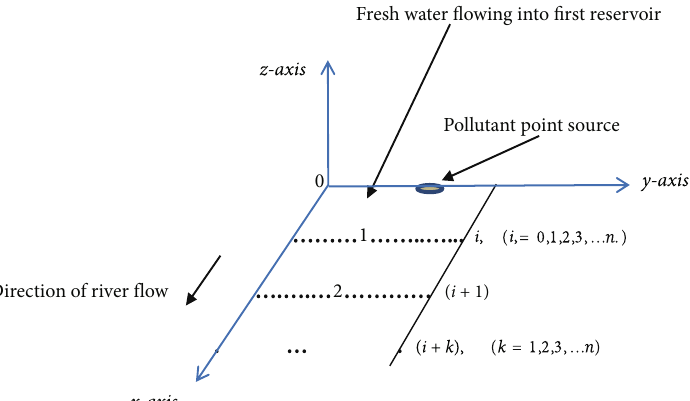
Figure 2: Setup for discretization of River fl ow channel into cascading water reservoirs ð i = 0, 1, 2, ⋯ , n is the position of cascade reservoir). Flowing water meets with the pollutant point source of predicted pollutant in the fi rst reservoir, and the mixing process proceeds downstream through the discretized